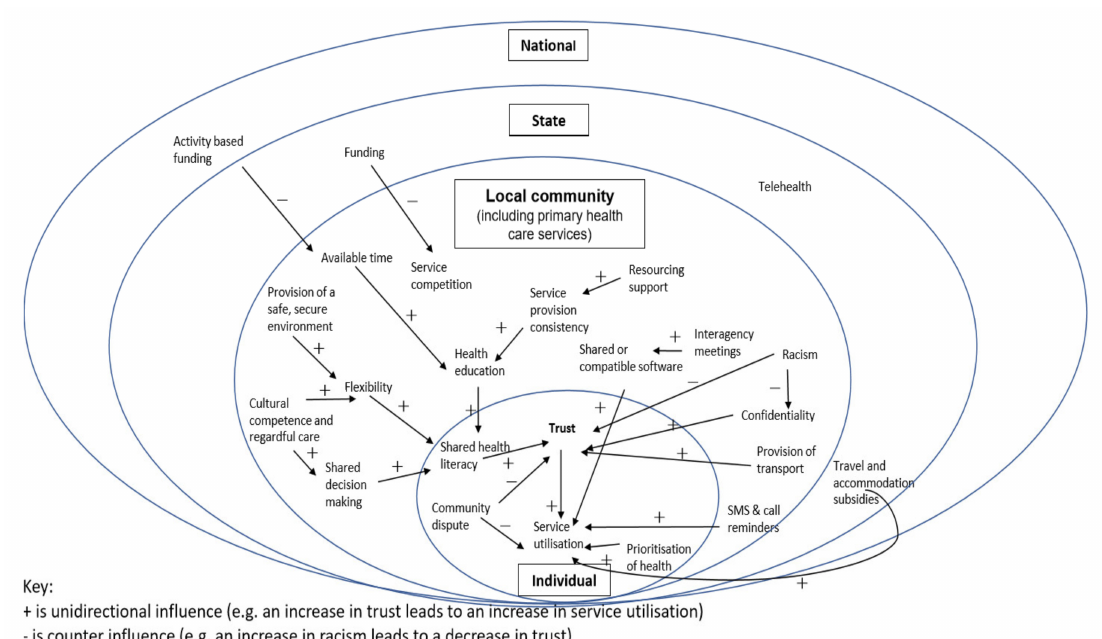
Figure 1. Interplay of themes across the ecological